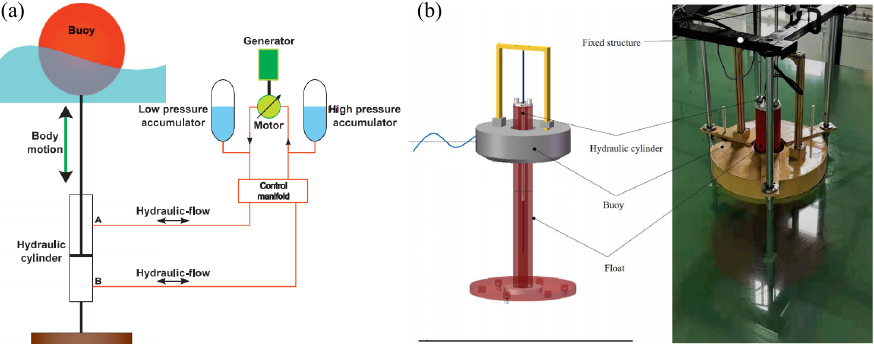
Figure 13. Hydraulic power take-off mechanisms with a schematic plot ( a ) and a hydraulic PTO system under tank testing ( b ), adapted from